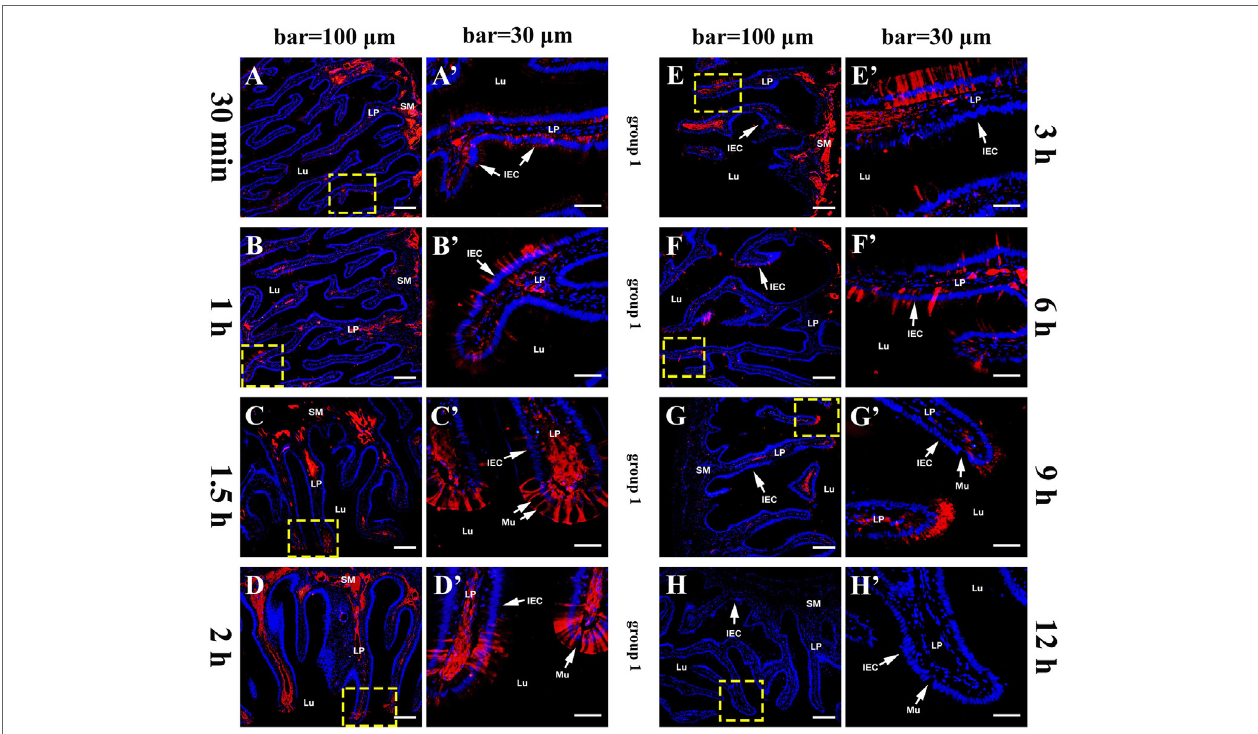
FigUre 2 | Tissue distribution of OVA in flounder hindgut of group 1 by indirect immunofluorescence assay at different time points after challenge. (a–h) The distribution of OVA at 30 min, 1 h, 1.5 h, 2 h, 3 h, 6 h, 9 h, and 12 h after challenge, respectively. Positive red fluoresce representing OVA was mainly located in LP submucosa and epithelial cells, accumulated with time and reached a peak at 2–3 h, then reduced from 6 h and disappeared at 12 h. Bar = 100 µm. (a ′ –h ′ ) ; the higher magnification view of the insert area (yellow box) in (a–h) , respectively, bar = 30 µm. The cell nuclei were counterstained in blue with DAPI. Abbreviations: LP, lamina propria; Lu, lumen; IECs, intestinal epithelial cells; Mu, mucus cells; OVA,